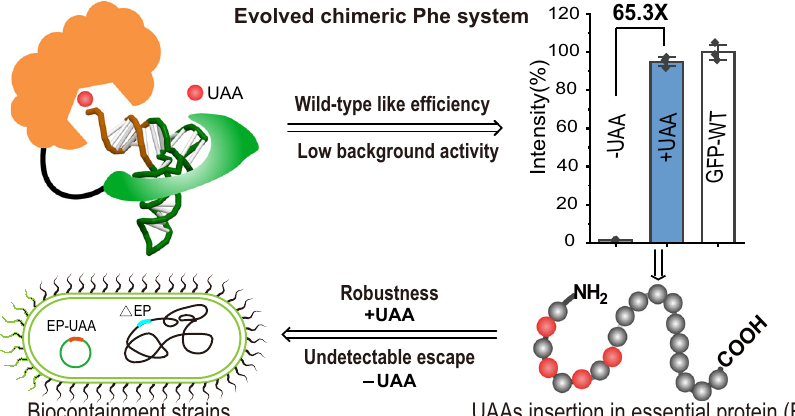
Fig. 1 Ef fi cient unnatural amino acids incorporation and generalizable synthetic auxotroph construction with the evolved chimeric Phe system. Schematic illustration of the engineering of orthogonal translation systems with wild-type like ef fi ciency in the presence of UAA and low background activity in the absence of UAA. The orthogonal translation system is used to construct UAA-dependent synthetic auxotroph by inserting amber codons into the essential gene. EP refers to essential